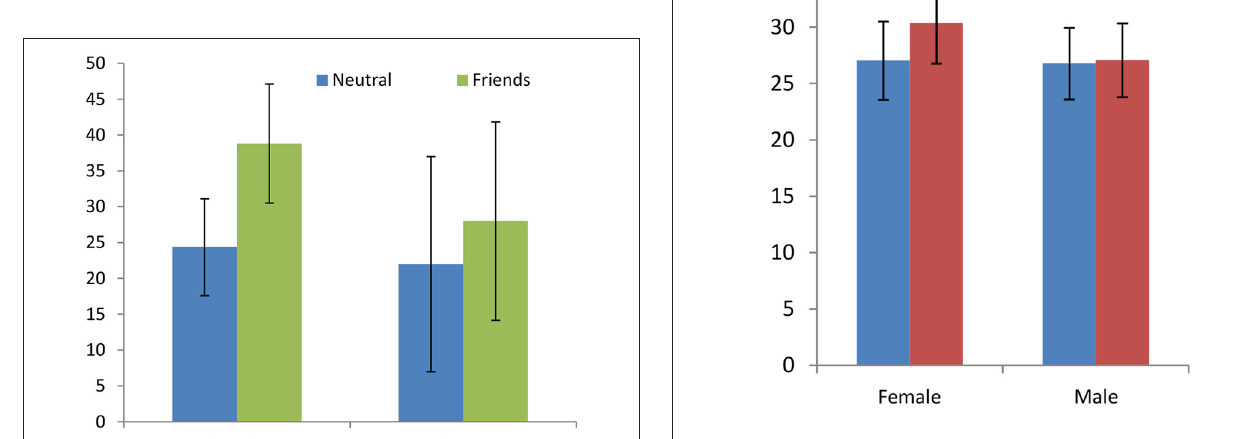
FIGURE 3 | Giving in the DG under two frames: Recipients are either not informed where the money comes from or informed that it comes from a game . The condition was known by the Dictator (Dreber et al., 2013). Women seem to react more to the treatment effect, but the effects are never